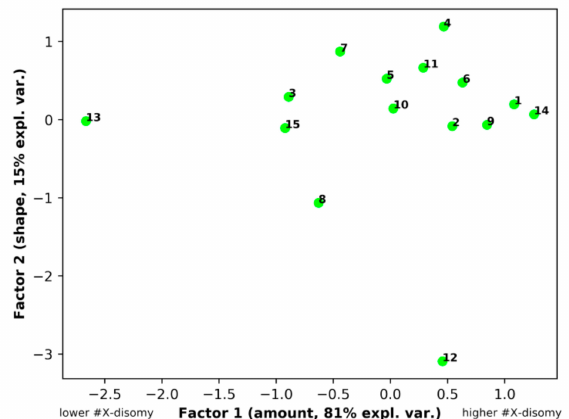
Figure 6. PCA results of the X-chromosome disomy distribution in the triploidy space for 15 malignant tumor types, designated as numbered in Table